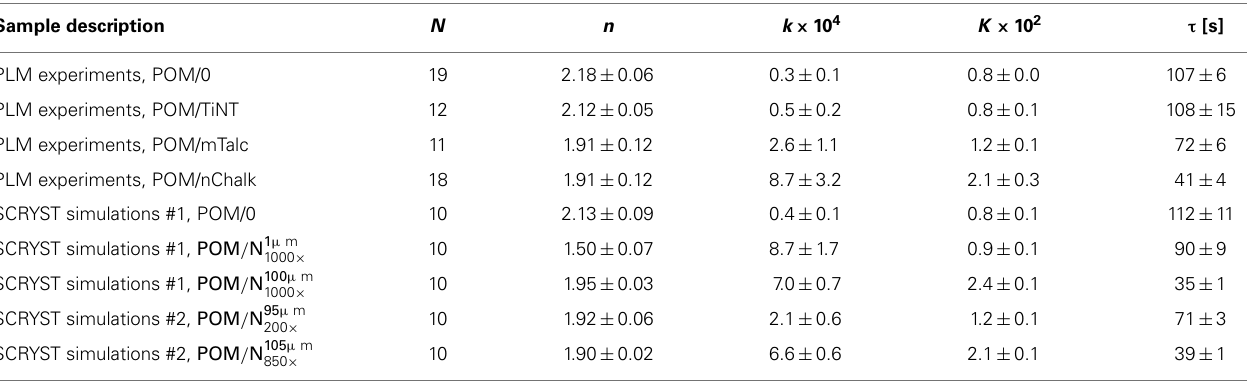
Table 1 | FinalAvrami parameters ( n , k , K , τ ) from PLM experiments and SCRYST simulations; N = number of experiments/simulations for given sample .